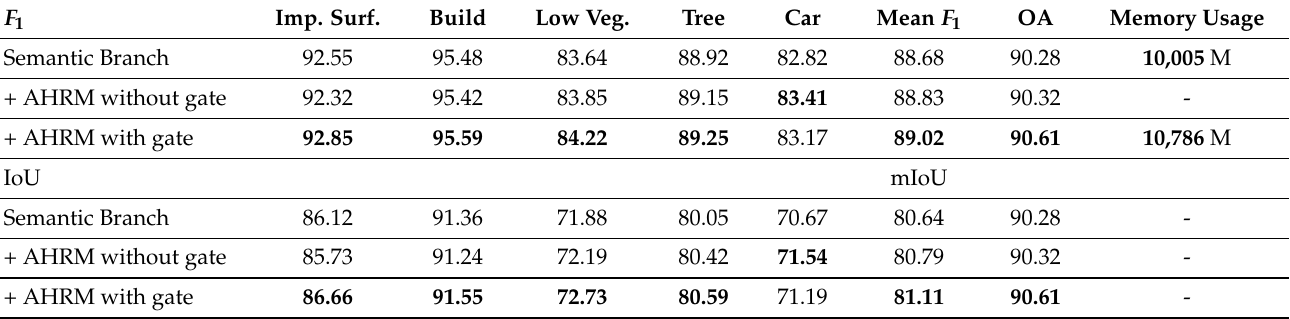
Table 5. Ablation study for the AHRM